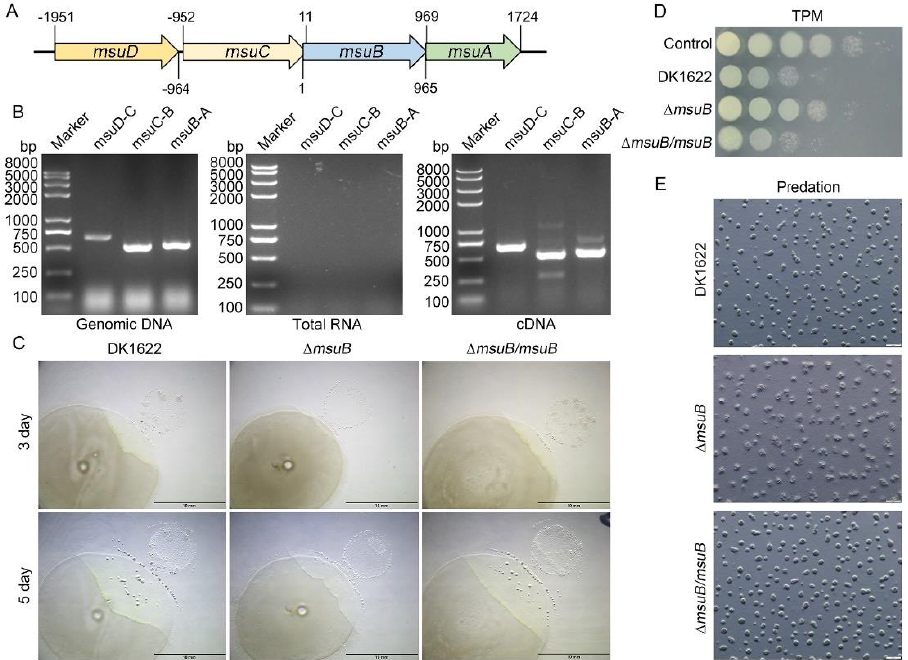
Figure 1. MsuB plays an important role in myxobacterial predation. ( A ) msuABCD locus. Start and stop codons are indicated; +1 indicates the first nucleotide in the msuB start codon. ( B ) Cotranscrip- tional analysis of the msuABCD cluster by reverse transcription – PCR. The templates were genomic DNA, RNA removed from genomic DNA, and cDNA, respectively. ( C ) Disruption of msuB affects the ability of M. xanthus to prey on P. aeruginosa . Predation assay on TPM (1.5% agar) plates. Scale bars = 10 mm. ( D ) The competition assay analyzed myxobacterial predation. After coculture of M. xanthus strains and PAO1 for 24 h, the cells were harvested and resuspended in 1 mL of MMC buffer. Subsequently, the cellular suspension was serially diluted in MMC buffer. For this, 3 µL of the sus- pensions (from 10 −1 to 10 −6 ) was spotted on LB agar plates supplemented with tetracycline (20 µg mL −1 ) from left to right. The plates were grown at 37 °C and photographed after 24 h. ( E ) Fruiting body formation was analyzed during the predation of P. aeruginosa . The plates were photographed by a stereomicroscope after 24 h of coculture. Scale bars = 500 µm.